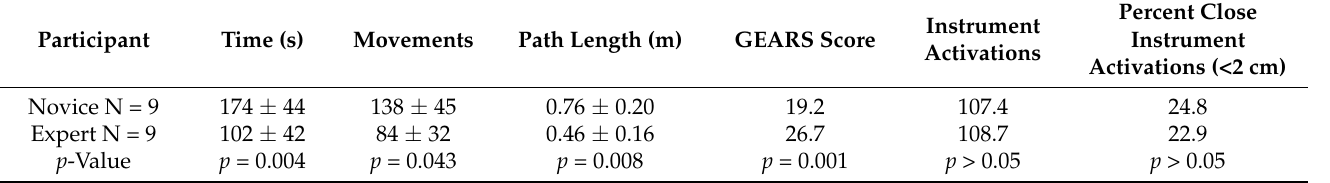
Table 1. Liver surgery simulator: assessment parameters for novice and expert surgeons in a validation study.